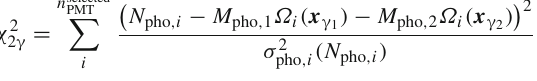
Fig. 9 Event display of the LXe photon detector for a 2 γ event (in a development view). The red points show the interaction positions of the two γ s projected to each face. Each circular marker denotes a PMT. The